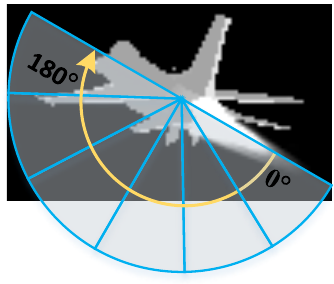
Figure 18. Schematic diagram of attack angle changes. Attack angle varies from 0 to 180 degrees at 30 degree